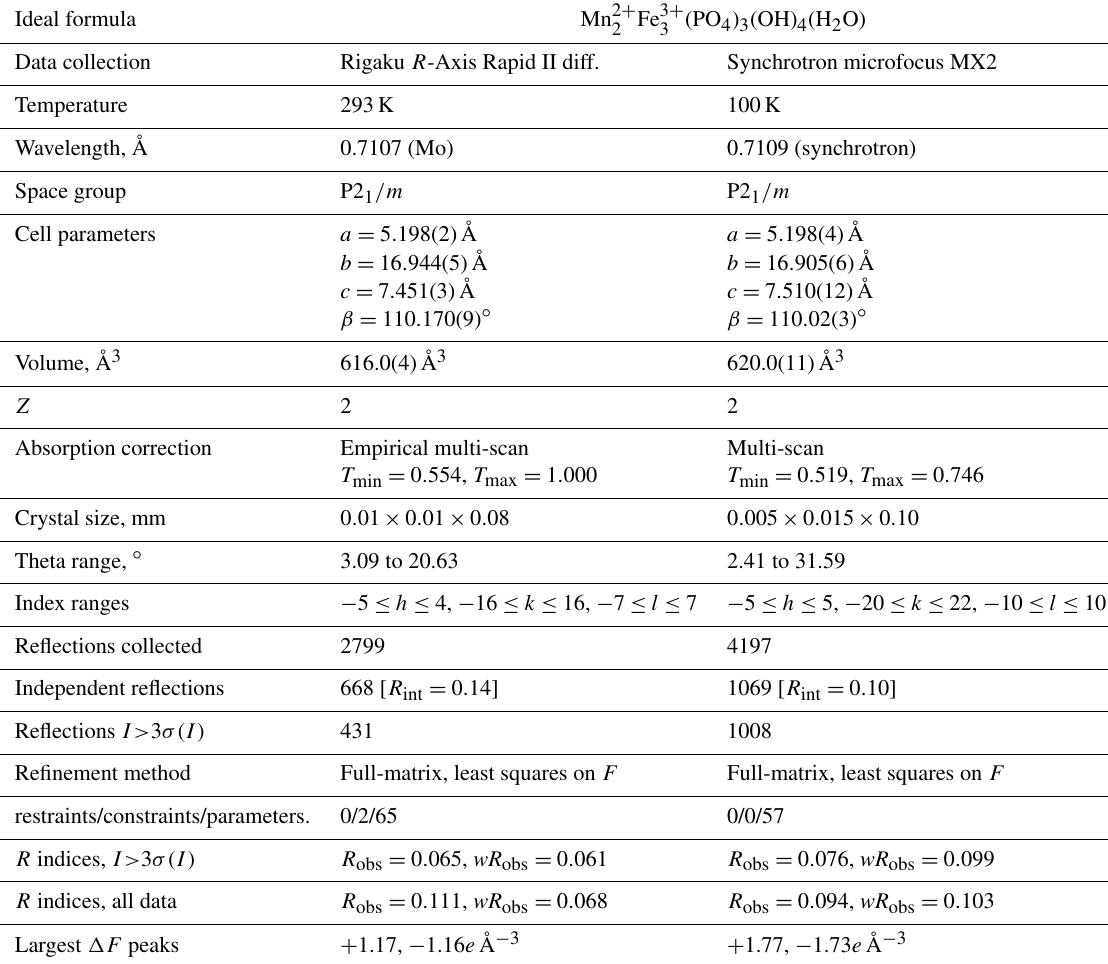
Table 4. Single-crystal X-ray data collection and refinement details. Ideal